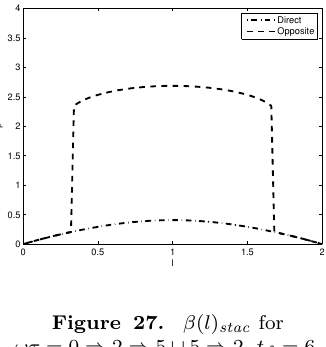
Figure 26. Droplets at ωτ = 0 ⇒ 2 ⇒ 5 ∪ 5 ⇒ 2, t f = 6.